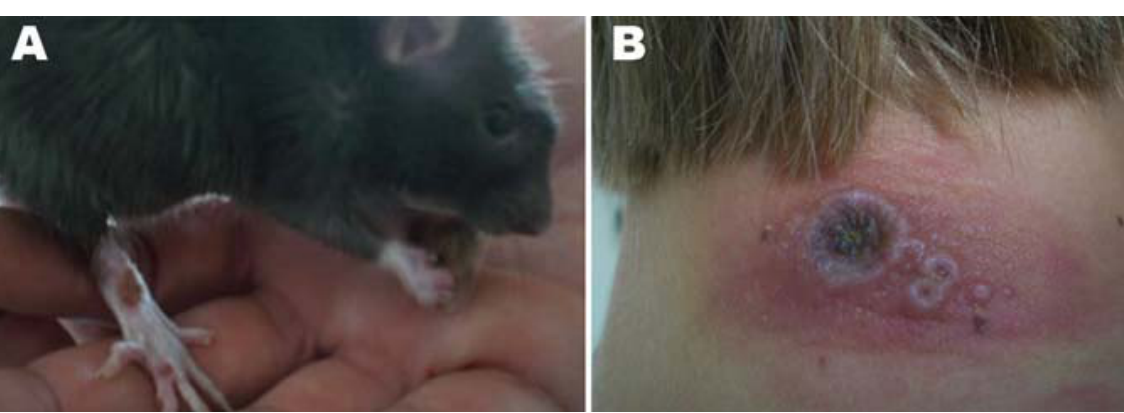
Figure 1. Clinical presentation of cowpox lesions on rats and humans during an outbreak in Germany, 2009. ( A ) Pet rat with lesions on the right hind limb; and ( B ) Neck lesions on a girl [10] (Photos originally printed in Emerging Infectious Diseases by Campe, H.; et al.